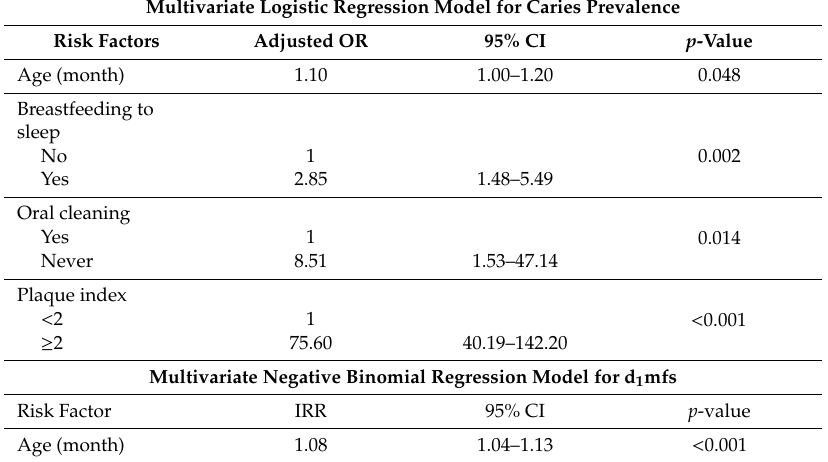
Table 4. Multivariate regression models for caries prevalence, d 1 mfs, and I-ECC. Multivariate Logistic Regression Model for Caries